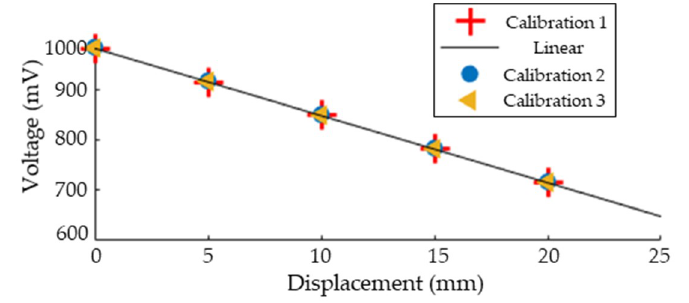
Figure 8. Displacement–voltage relationships of three times calibration.